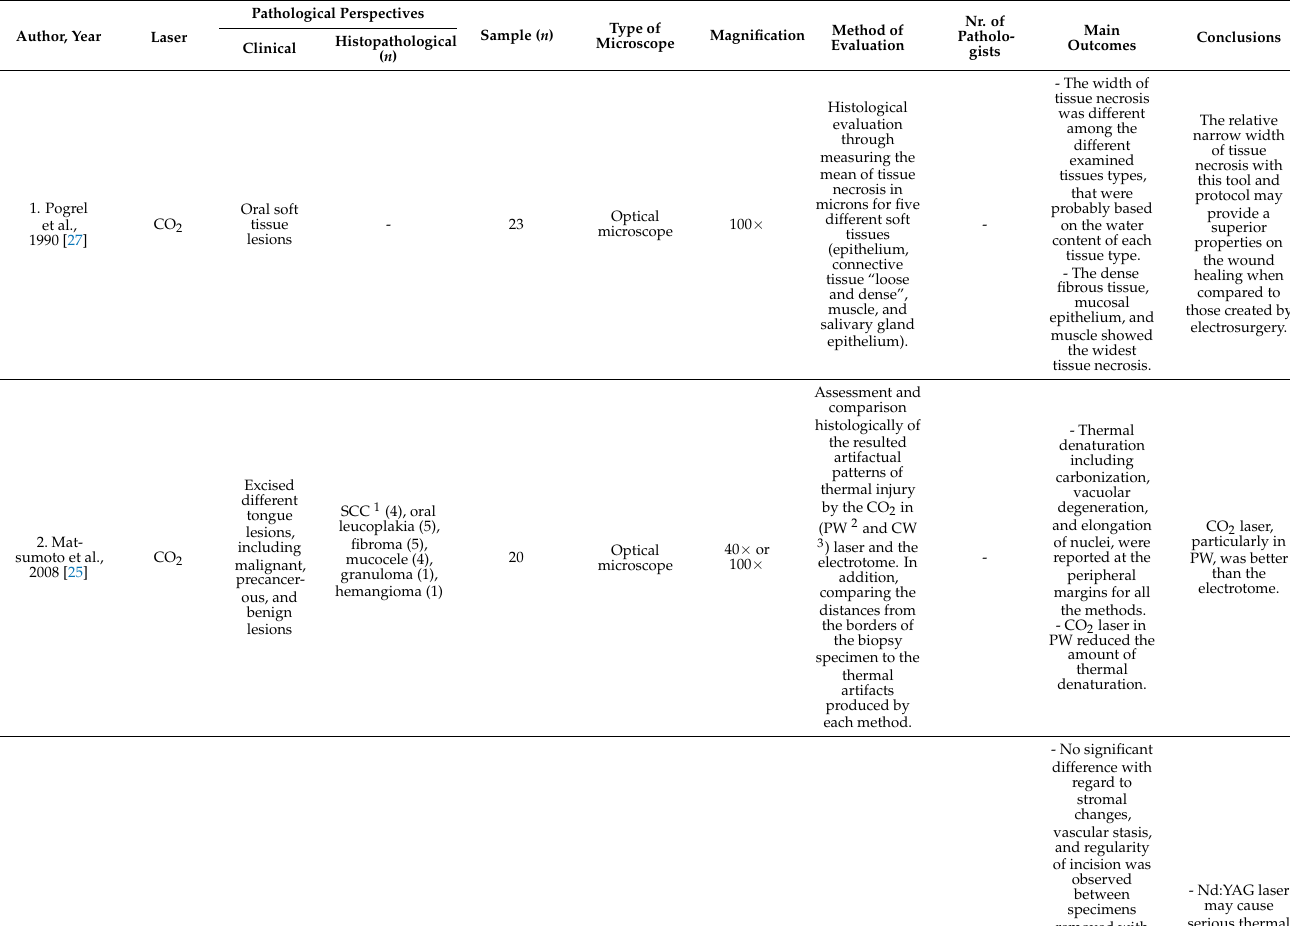
Table 3. Overview and evaluation details of all included clinical